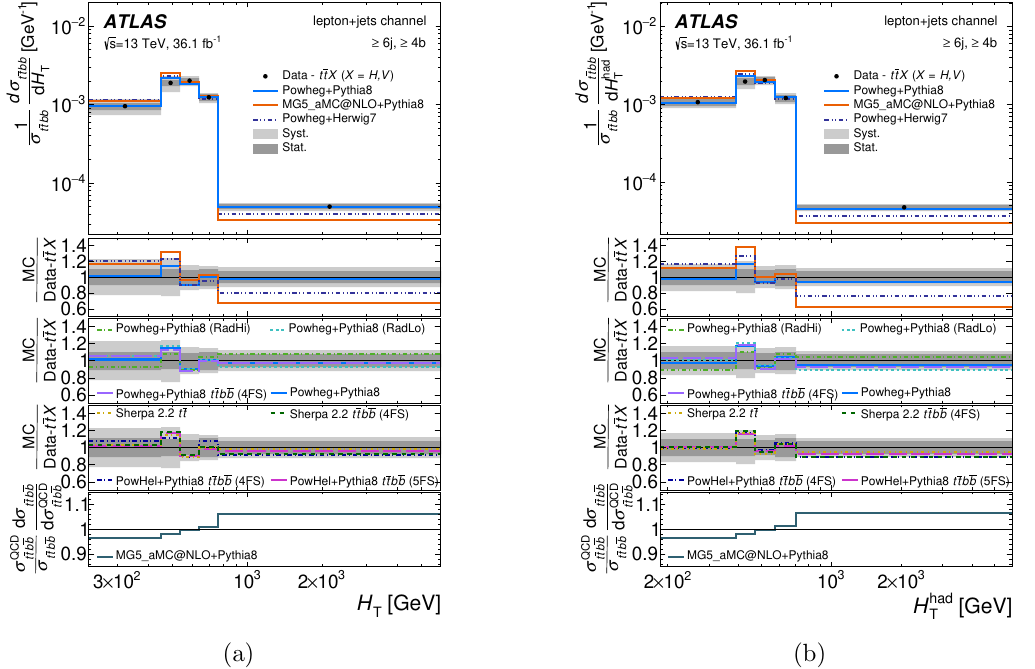
Figure 10. Relative di(cid:11)erential cross-sections as a function of (a) H T , (b) H had least four b -jets in the lepton+jets channel compared with various MC generators. The t (cid:22) tH and t (cid:22) tV contributions are subtracted from data. Four ratio panels are shown, the (cid:12)rst three of which show the ratios of various predictions to data. The last panel shows the ratio of predictions of normalised di(cid:11)erential cross-sections from MadGraph5 aMC@NLO+ Pythia 8 including (numerator) and not including (denominator) the contributions from t (cid:22) tV and t (cid:22) tH production. Uncertainty bands represent the statistical and total systematic uncertainties as described in section 8. Events with H T ( H had ) values outside the axis range are not included in the plot. T